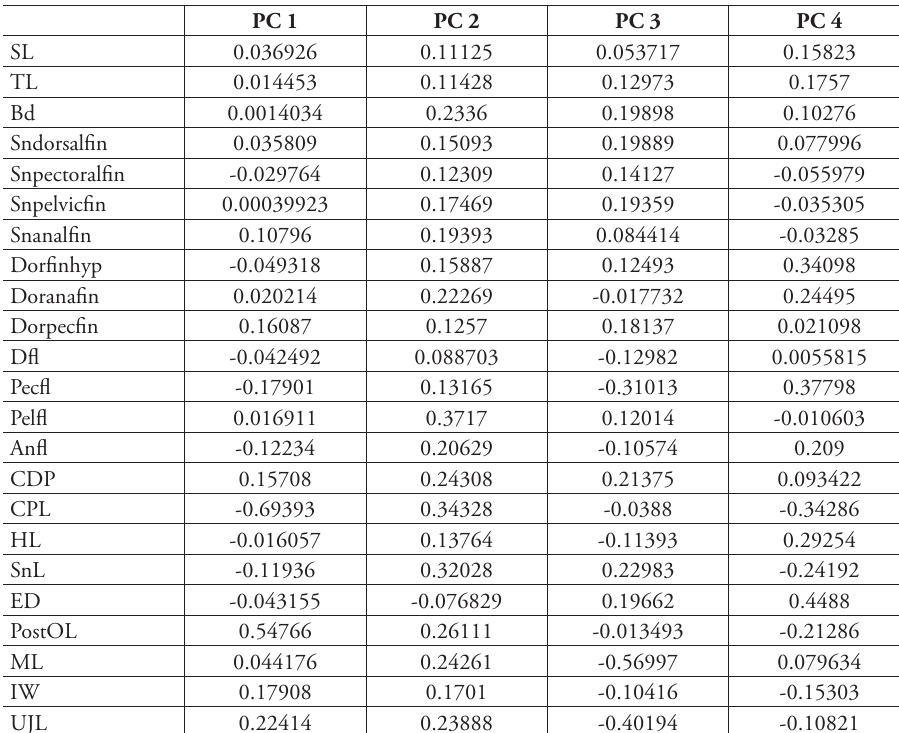
Table 3. Eigenvector for first four principal components (PC) between Hyphessobrycon klausanni sp. n., H. acaciae , H. mavro , H. metae and H. niger . Abbreviations same as Table